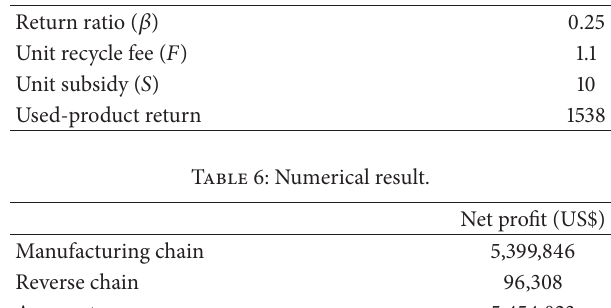
Table 5: Other parameters.